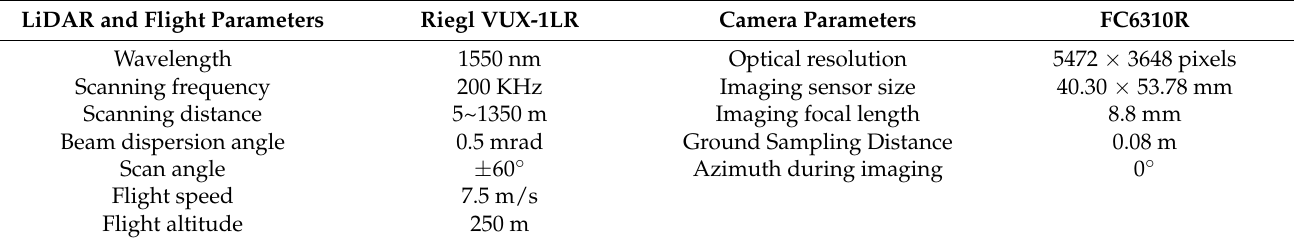
Table 1. The LiDAR scanner, camera, and flight